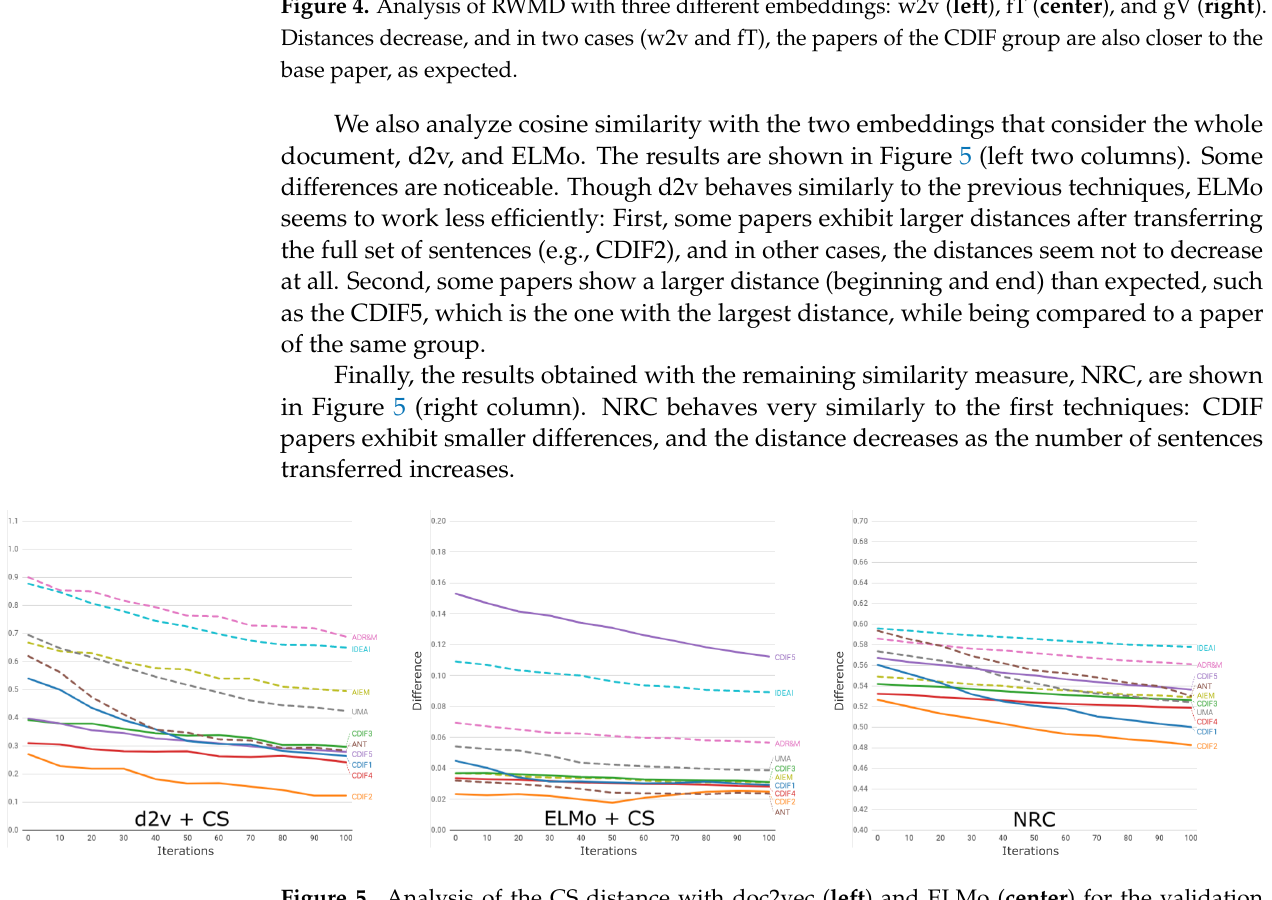
Figure 5. Analysis of the CS distance with doc2vec ( left ) and ELMo ( center ) for the validation scenario. Here, ELMo does not seem to behave as expected, since some papers do not exhibit decreasing distance as their contents become more similar. On the other hand, NRC ( right ) behaves as expected, with distance decreasing, and the papers within the same group showing smaller